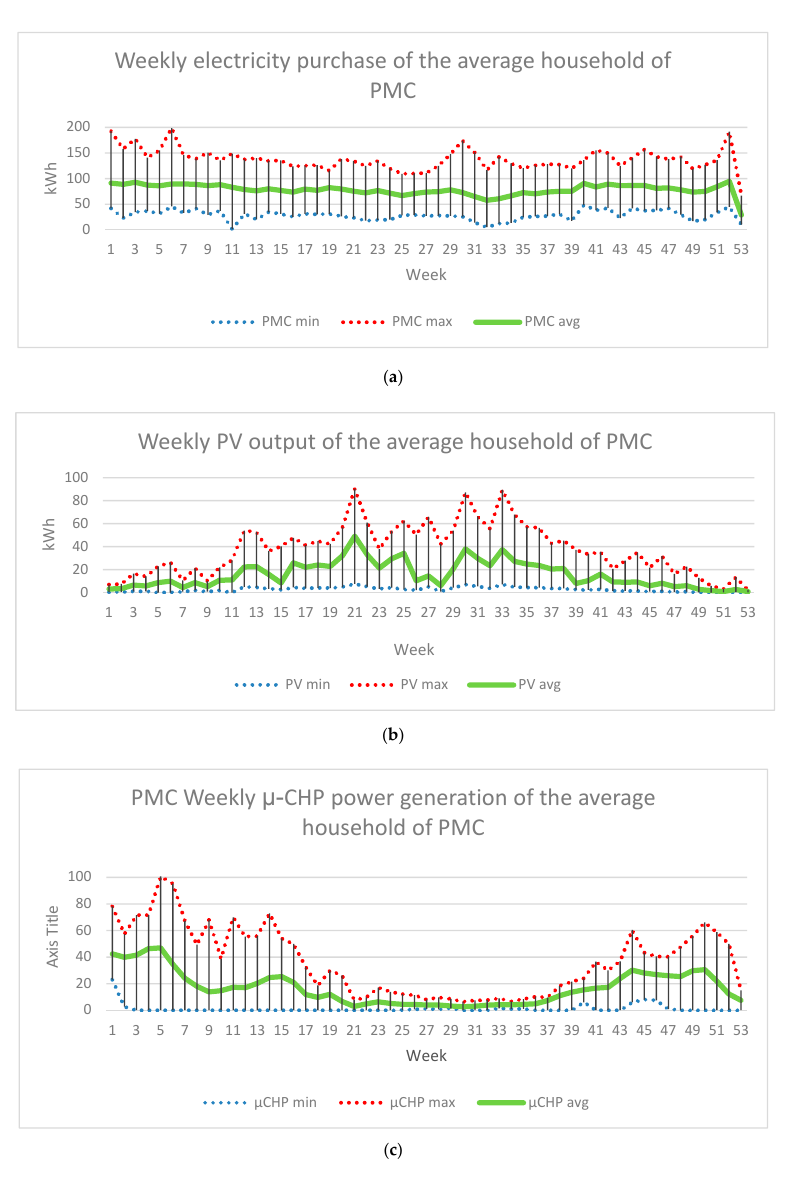
Figure 4. PowerMatching City (PMC) weekly values of ( a ) electricity purchase, ( b ) PV output, and ( c ) μ‐ CHP (micro ‐ combined heat and power) power generation.